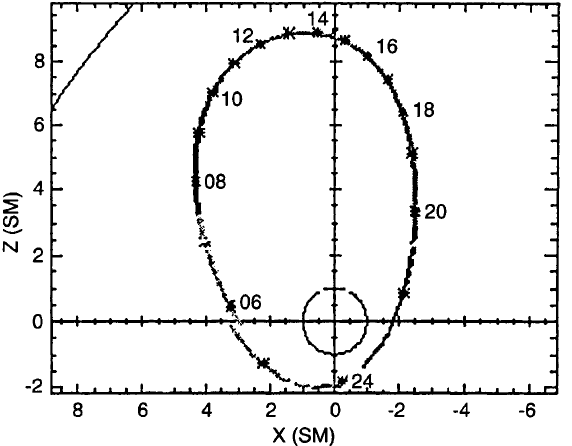
Fig. 2. Example orbit of the Polar satellite. See http://www-